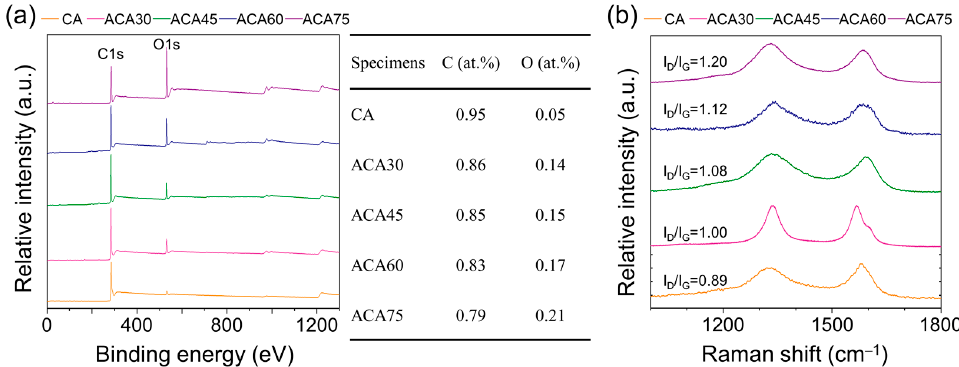
Figure 4. ( a ) XPS graphs with elemental composition (evaluated by XPS measurement) of samples and ( b ) Raman spectrum of samples with I D /I G ratio.